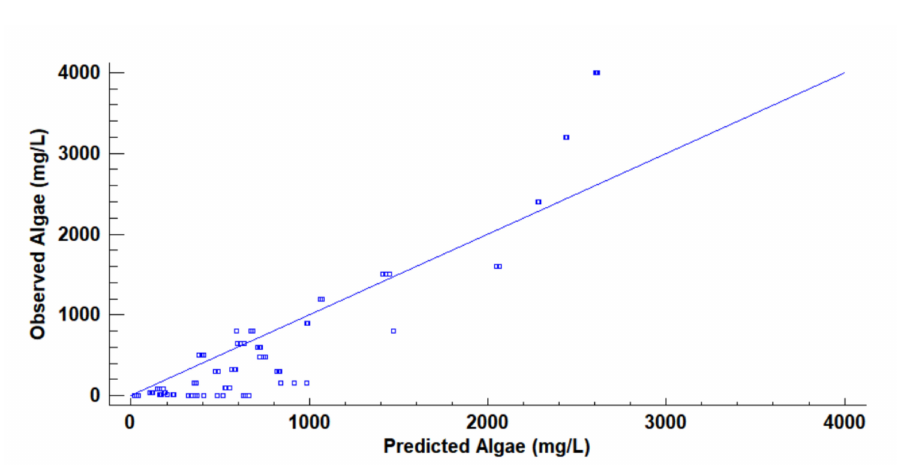
Figure 10. Observed versus predicted values of algae concentration with Equation (2).